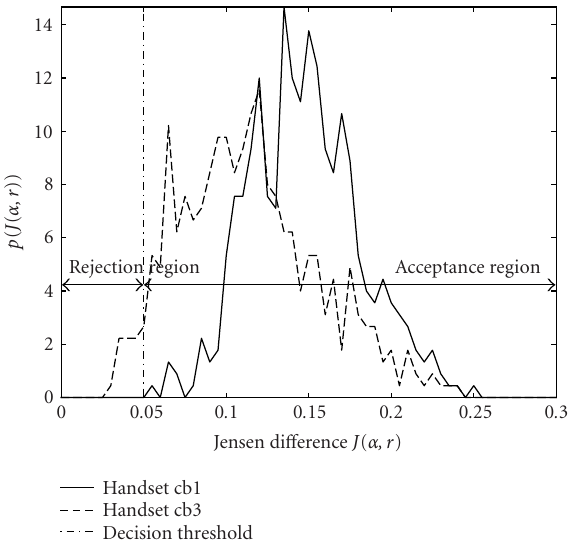
Figure 5: The distribution of the Jensen Di ff erence J ( (cid:1) α , (cid:1) r ) corre- sponding to the seen handset cb1 and the unseen handset cb3.